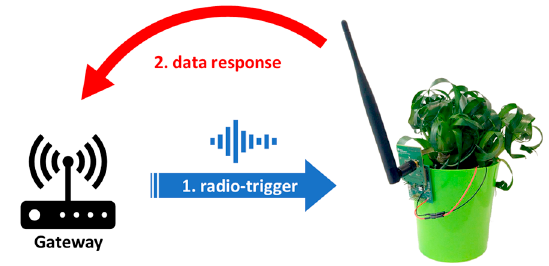
Figure 2. Application scenario. The data aggregator requests data by triggering the sensors powered by the PMFC.